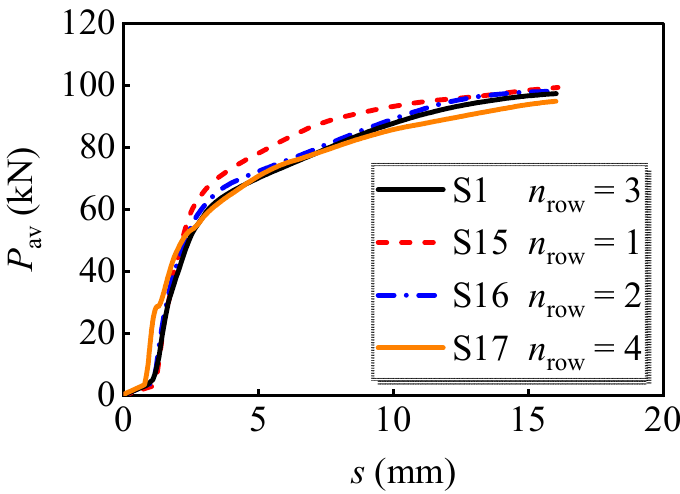
Figure 16. Average load versus slip curves for models with different row numbers of bolts.